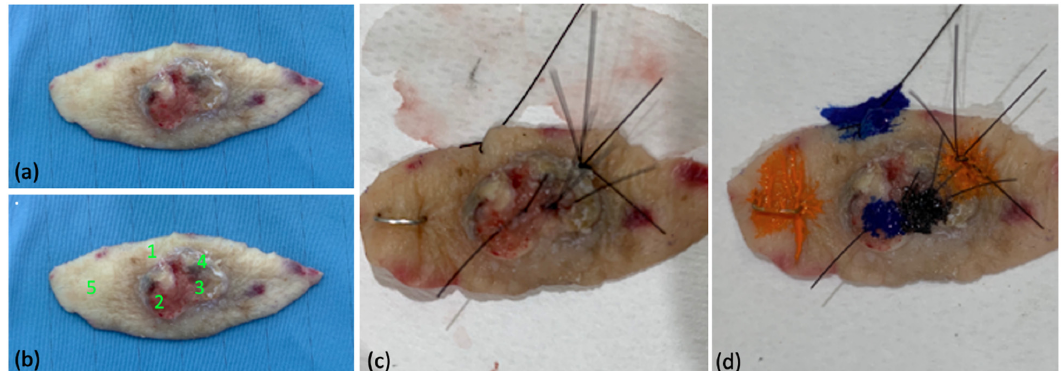
Figure 2. Example of lesional and healthy skin reference points on excised specimen: ( a ) specimen after excisional biopsy; ( b ) ex vivo identification of control points (1,5) and lesional points (2,3,4) for 400–430 nm irradiation; ( c ) suture stitches as reference for histologic analysis, ( d ) tissue marking dyes before histopathological examination.